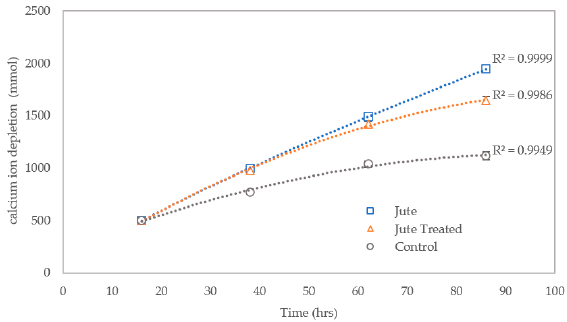
Figure 8. Cumulative reduction in concentration of calcium ions in columns between cementation medium (CM) treatments one and four, with error bars showing standard errors of the means.